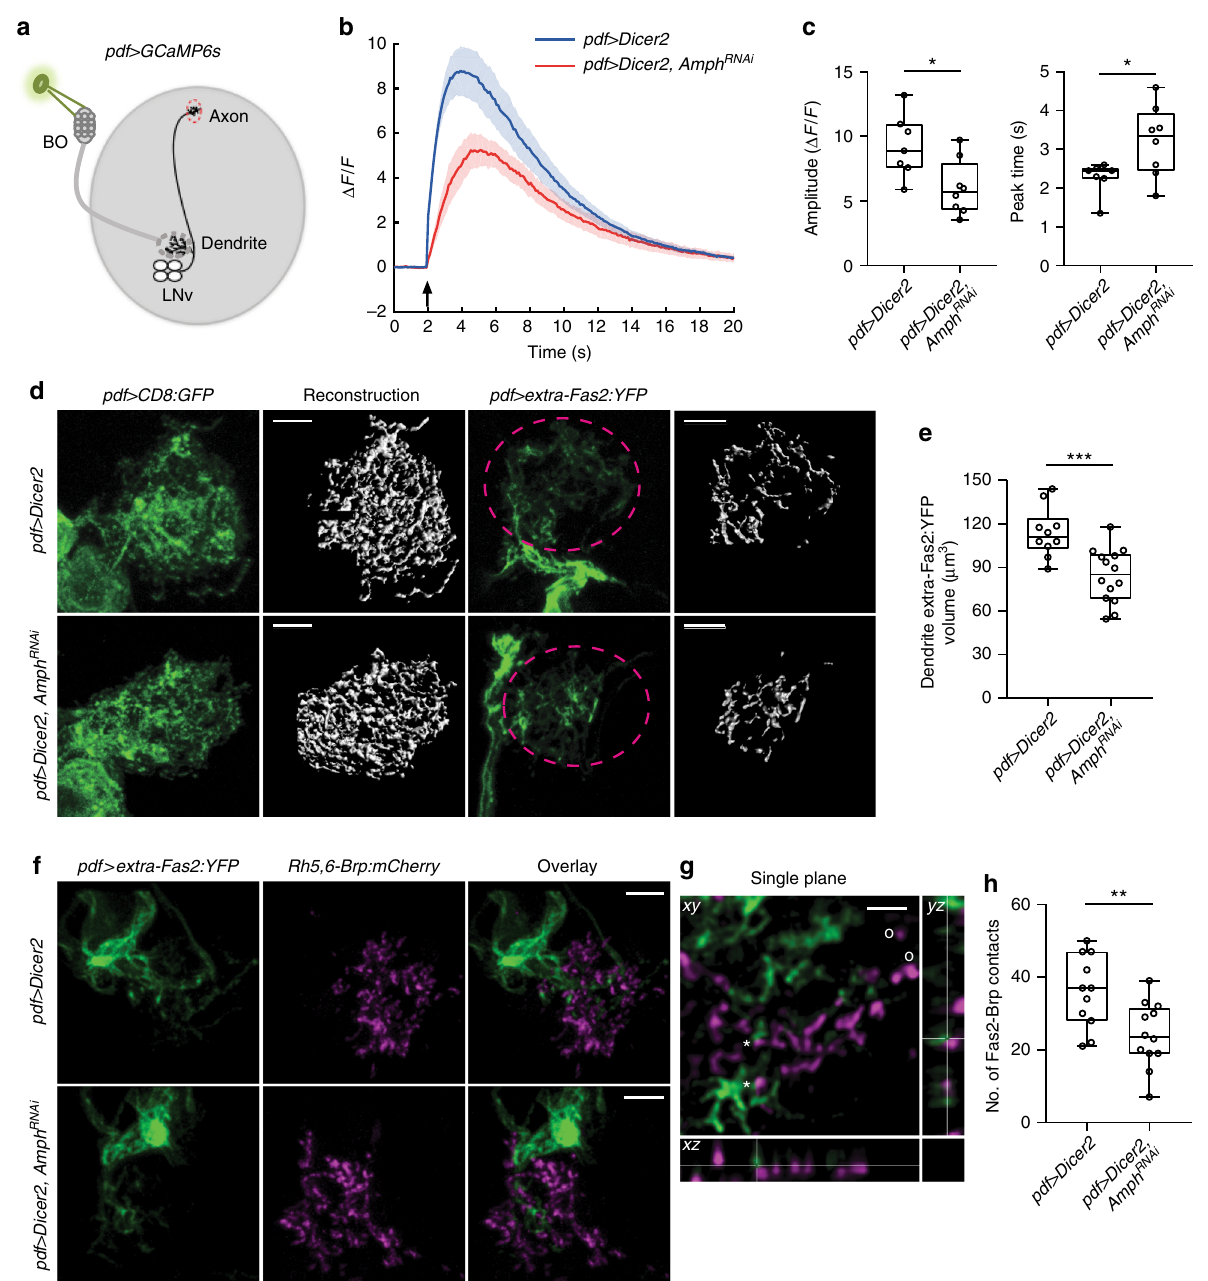
Fig. 8 Amph is required for postsynaptic organization and normal synaptic transmission. a Schematic diagram for calcium imaging experiments. BO- mediated synaptic transmission is received by LNv dendrites (dashed gray circle) and measured by the changes of GCaMP6s signals in the axonal terminal region of LNvs (dashed red circle). b Knocking-down Amph led to reductions in light-induced responses in LNvs. The changes in GCaMP signal ( Δ F/F) were plotted. Data are presented as line graph showing Mean± SEM. Arrow indicates the delivery of the light stimulation. c Quanti fi cation reveals reduced amplitude and delayed peak time of calcium responses in LNvs expressing Amph RNAi. n = 7, pdf > Dicer2 ; n = 8, pdf > Dicer2, Amph RNAi . Statistical signi fi cance was assessed by two-tailed Student ’ s t -test. Amplitude: t 13 = 2.742, P = 0.017. Peak time: t 13 = 2.491, P = 0.027. d Disrupted dendritic Fas2 distribution in LNvs expressing Amph RNAi. While CD8:GFP ( pdf > CD8:GFP , left) shows no change, the volume of dendritic extra-Fas2:YFP ( pdf > extra- Fas2:YFP , right) is reduced in LNvs with Amph knockdown. Representative projected confocal images (green) and 3D reconstructions (gray) are shown. Scale bar, 5 μ m. e Quanti fi cation of dendritic extra-Fas2:YFP based on 3D reconstructions. n = 10, pdf > Dicer2 ; n = 14, pdf > Dicer2, Amph RNAi . Statistical signi fi cance was assessed by two-tailed unpaired Student ’ s t -test. t 22 = 3.969, P < 0.001. f – h Amph knockdown reduces the synaptic distribution of Fas2. f Representative projected confocal images of LNvs are shown. Scale bar, 5 μ m. Genotypes are as indicated. g A representative single optic section image illustrating the dendritic Fas2 ( extra-Fas2:YFP , green) contacting the presynaptic site marked by Brp ( Rh5,6-Brp , magenta). Contacts are indicated by *, non- contacts by o. Scale bar, 2 μ m. h Quanti fi cations of the number of contacts between Brp puncta and extra-Fas2:YFP. Knocking-down Amph led to reduced number of Fas2-Brp contacts. n = 11, pdf > Dicer2 ; n = 12, pdf > Dicer2, Amph RNAi . Statistical signi fi cance was assessed by two-tailed Student ’ s t- test. t = 2.988, P = 0.007. Data are presented as box plot (box, 25 – 75%; center line, median) overlaid with dot plot (individual data points). ns, not signi fi cant; 21 *P < 0.05, **P < 0.01, ***P <